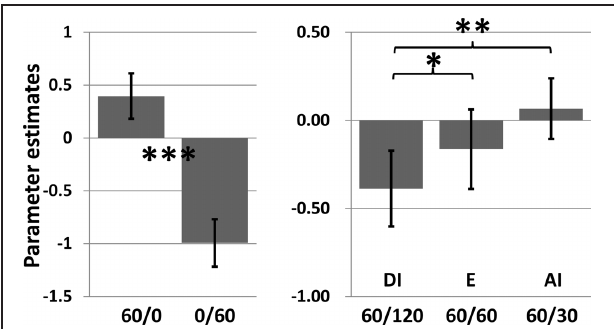
FIGURE 5 | Results for the anatomically defined ROI: Mean parameter estimates for the different conditions averaged across all voxels of the ROI (cf. Figure 3). The left side demonstrates the strong responsiveness of the area to rewards per se . The right side shows a significant main effect of relative payoff on activation in this area [within-subject ANOVA: ( F ( 2 , 59 ) = 6 . 556, P = 0 . 008)] with stronger activation in the E ( t 63 = 2 . 32, P = 0 . 023) and advantageous inequity ( t = 2.92, P < 0 . 001) condition than for the disadvantageous inequity condition. Error bars indicate standard error of means and are not informative with regard to (within-subjects) statistical inference.